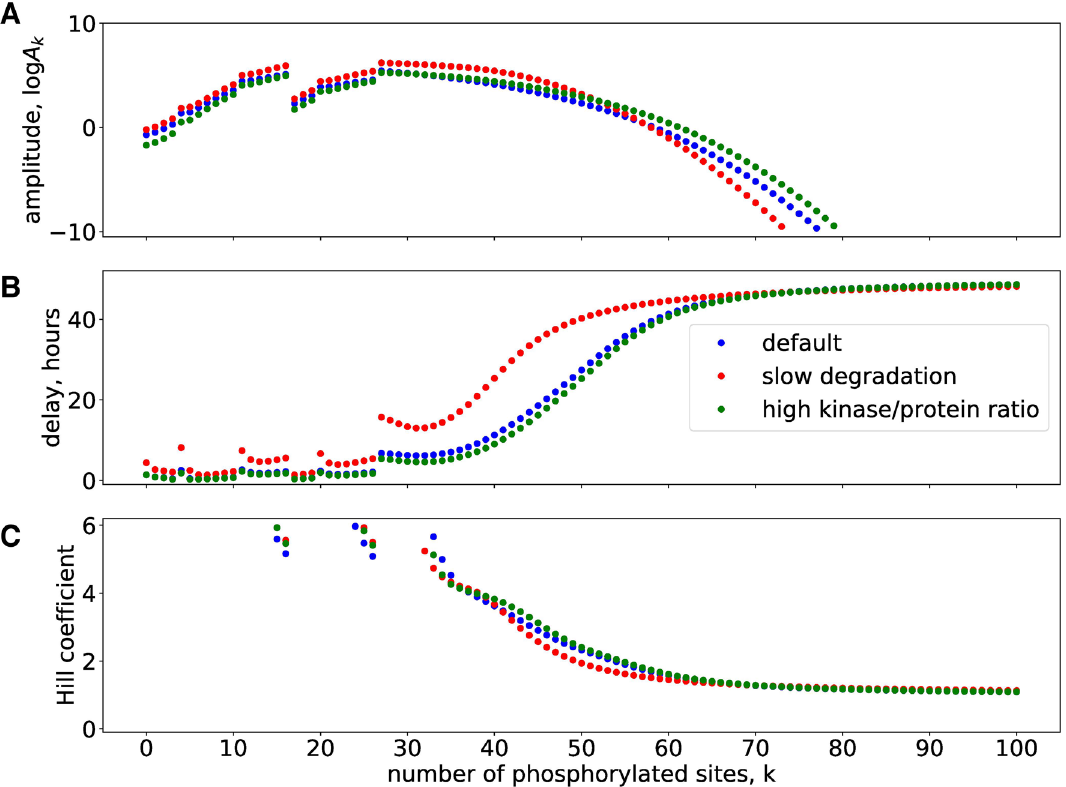
Figure 8. Intermediate phosphorylation levels exhibit large amplitudes, delays and ultrasensitivity: (A) shows log10 values of amplitude for phosphorylated species. (B) depicts delays and (C) shows Hill coefficients for phosphorylated species. Note, that Hill coefficients for most values of our k < 35 exceed 6 and are not